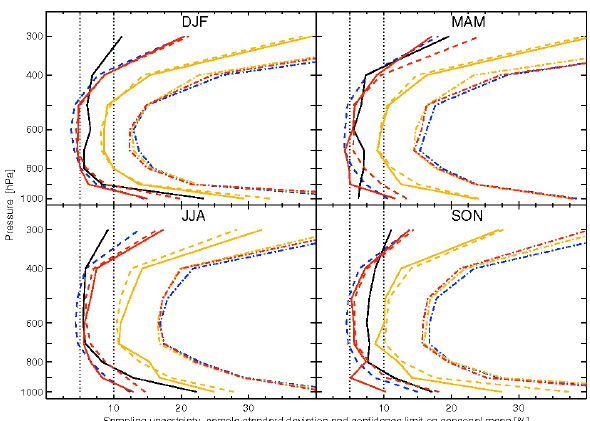
Fig. 5. Vertical profiles of the climatological sampling uncertainty (2 . 6 · s samp , N f , see Sect. 3.5.2) derived from Frankfurt MOZAIC seas , clim data for the four seasons (orange and red solid lines for the fre- quency of N f = 4 and 12, respectively). The blue dot-dashed line represents the average value of the sample standard deviation s seas , yr derived from the whole morning data set (average across years for each season and level), and the orange and red dot-dashed line the average values of the sample standard deviation s i,N f seas , yr de- rived from the subsamples (average across years and across sub- samples for each season, level and frequency). Similarly, the dashed lines represents the average estimate of the 95% confidence limits on the seasonal means ( t 0 . 05 · se seas , yr in blue and t 0 . 05 · se i,N f seas , yr in orange and red). The black solid line shows the profiles of ozone in- ter annual variability as calculated in Sect. 4.2. The vertical dotted lines are the 5 and 10% value lines, uncertainty values commonly quoted for measurement error of ozone